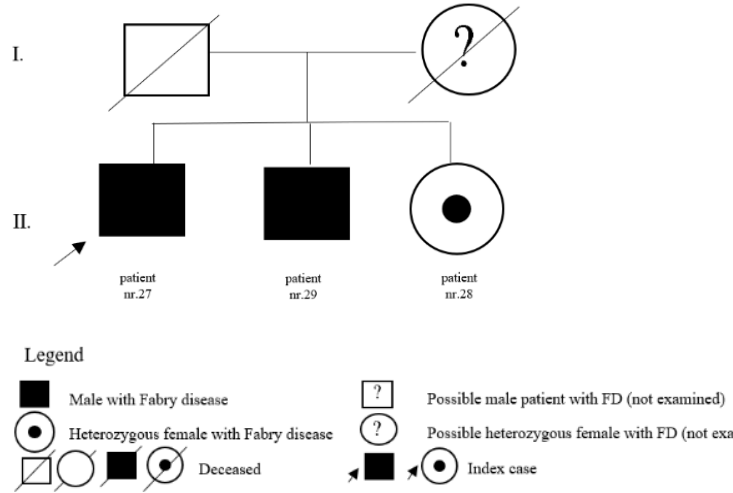
Figure 5. Pedigree of family with mutation c.334C>T.